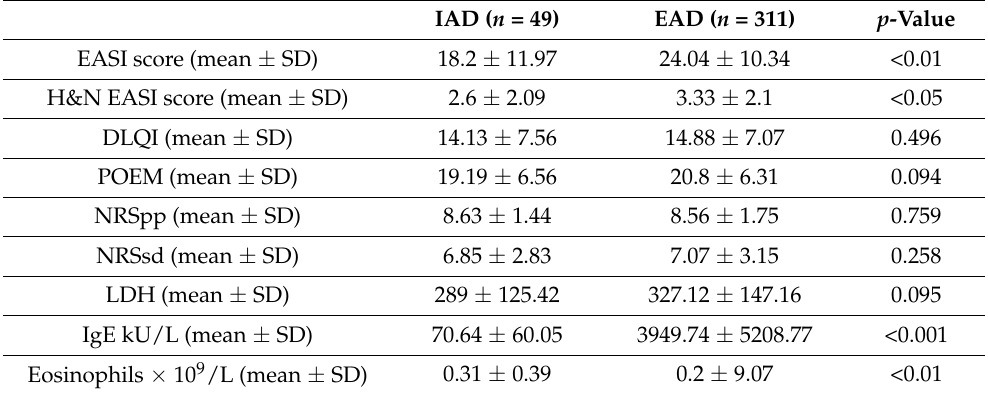
IAD: Intrinsic atopic dermatitis; EAD: extrinsic atopic dermatitis; SD: standard deviation; EASI: eczema area severity index; H&N = head and neck; DLQI: dermatology life quality index; POEM: patient-oriented eczema measure; NRSpp: numerical rating scale peak of pruritus; NRSsd: numerical rating scale sleep